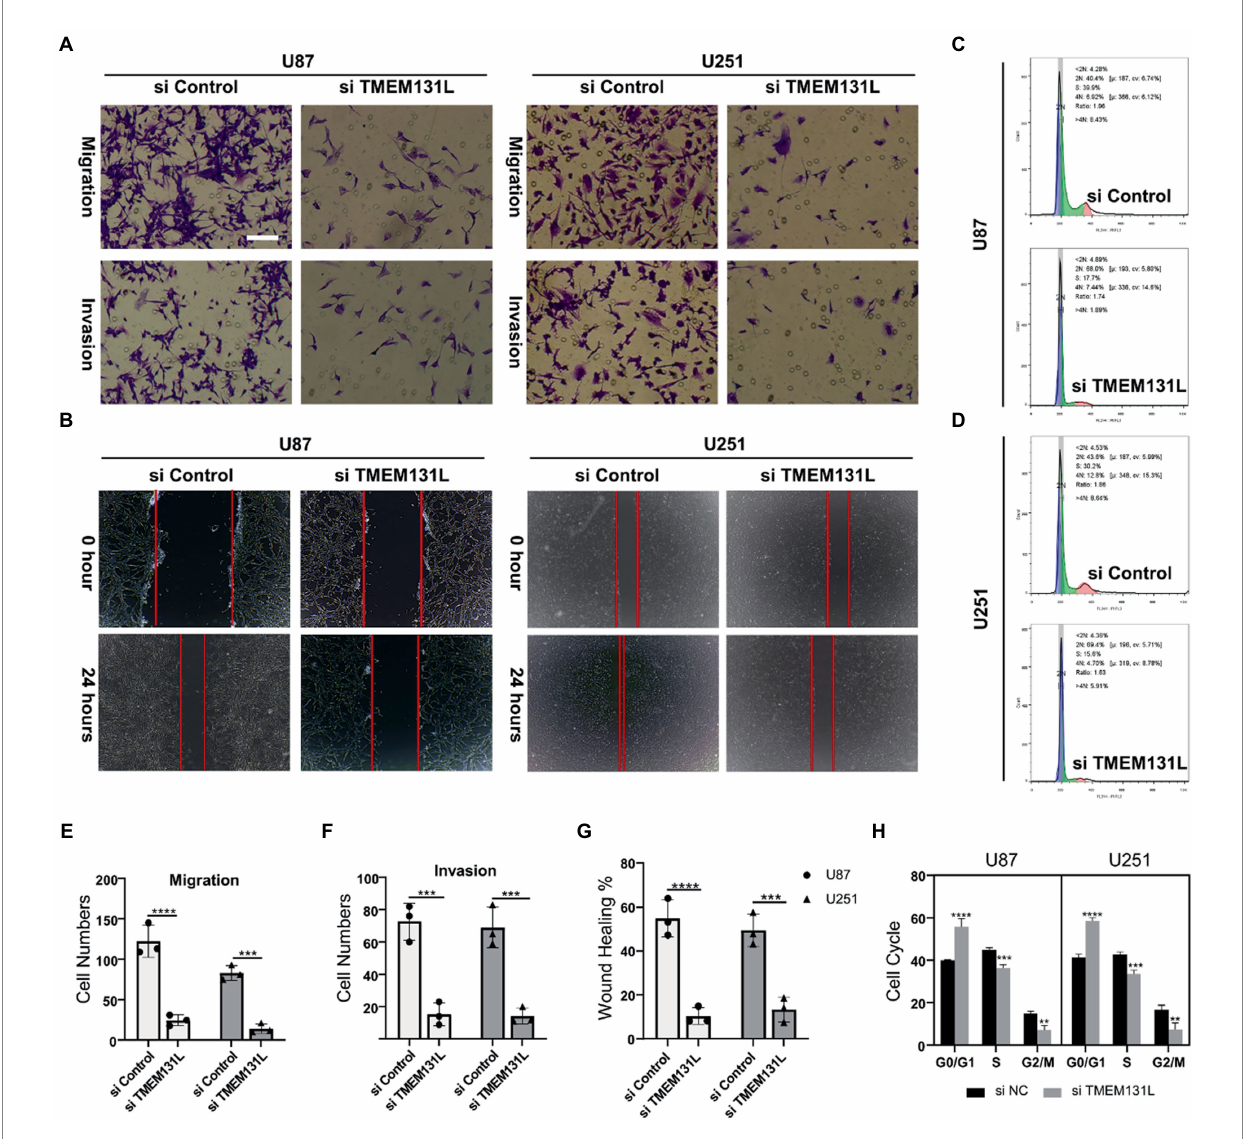
FIGURE 18 Decreased migration and invasive ability of U87 and U251 after interference with TMEM131L. (A,E,F) After interference with TMEM131L , the migratory and invasive capacity of U87 and U251 was decreased and cell numbers were quantified ( n = 3); (B,G) After interfering with TMEM131L , the invasive ability of U87 and U251 was decreased and quantified for wounds ( n = 3); (C,D,H) Prolonged cell cycle of U87 and U251 after interference with TMEM131L expression ( n = 3). ** p ≤ 0.01, *** p ≤ 0.001, and **** p ≤